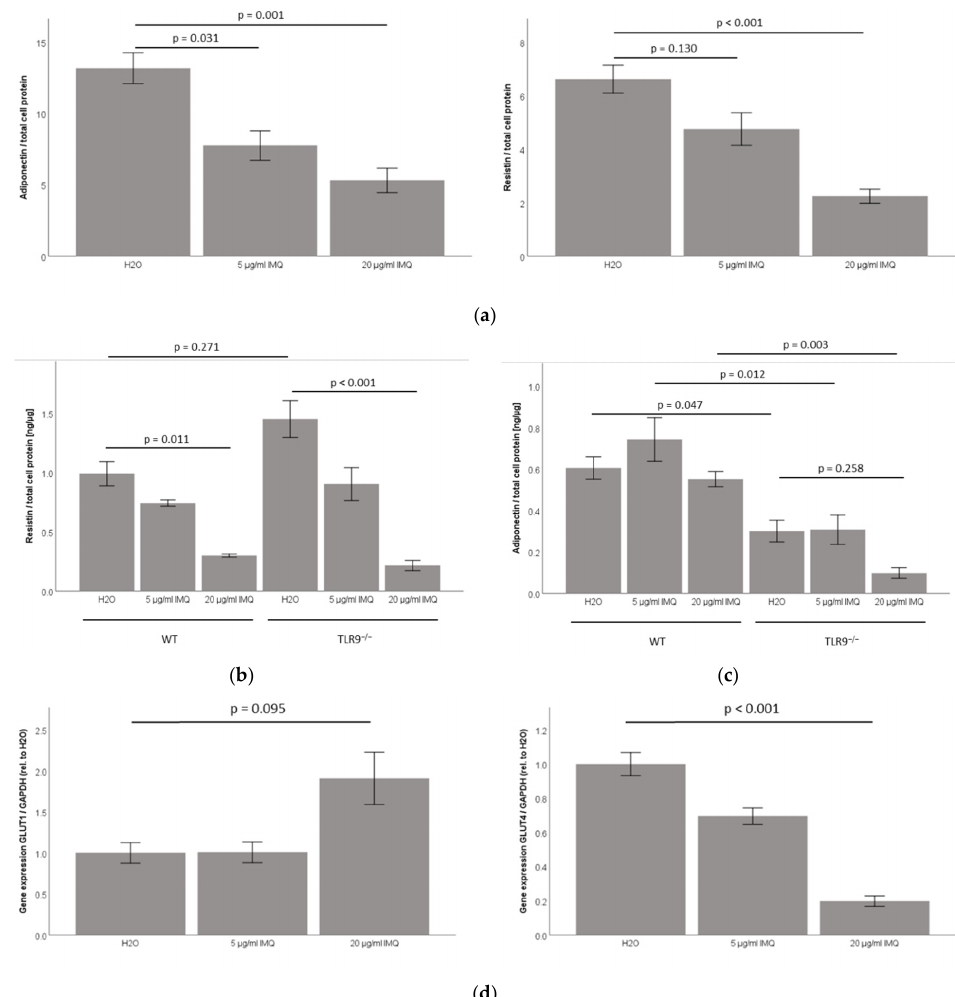
Figure 3. TLR7 agonist imiquimod inhibits adiponectin and resistin protein accumulation in 3T3-L1 adipocyte cell-culture supernatants, inhibits resistin accumulation in primary murine TLR9 wt/wt and TLR9 − / − subcutaneous adipocyte cell-culture supernatants and inhibits Glut4 mRNA expression in 3T3-L1 adipocytes in vitro. Mature 3T3-L1 adipocytes and primary adipocytes derived from subcutaneous adipose tissue of female TLR9 − / − and TLR9 wt/wt (WT) mice were treated with TLR7 agonist imiquimod (IMQ) for 18 h. ( a ) In 3T3-L1 adipocytes, supernatant adiponectin and resistin levels were downregulated significantly and in a dose-dependent manner by IMQ treatment ( n = 6); ( b ) in primary cells from murine adipose tissues, resistin concentration in cell-culture supernatants was significantly downregulated by IMQ ( n = 4–6) in both TLR9 − / − and TLR9 wt/wt adipocytes; ( c ) adiponectin concentration in cell-culture supernatants remained unaffected by IMQ treatment in both TLR9 − / − and TLR9 wt/wt adipocytes, while adiponectin levels were generally decreased in TLR9 − / − as compared to TLR9 wt/wt adipocytes ( n = 4–6); ( d ) GLUT4 mRNA levels were strongly and dose-dependently decreased in IMQ-stimulated 3T3-L1 adipocytes, whereas GLUT1 levels were not significantly affected by IMQ treatment ( n = 11).